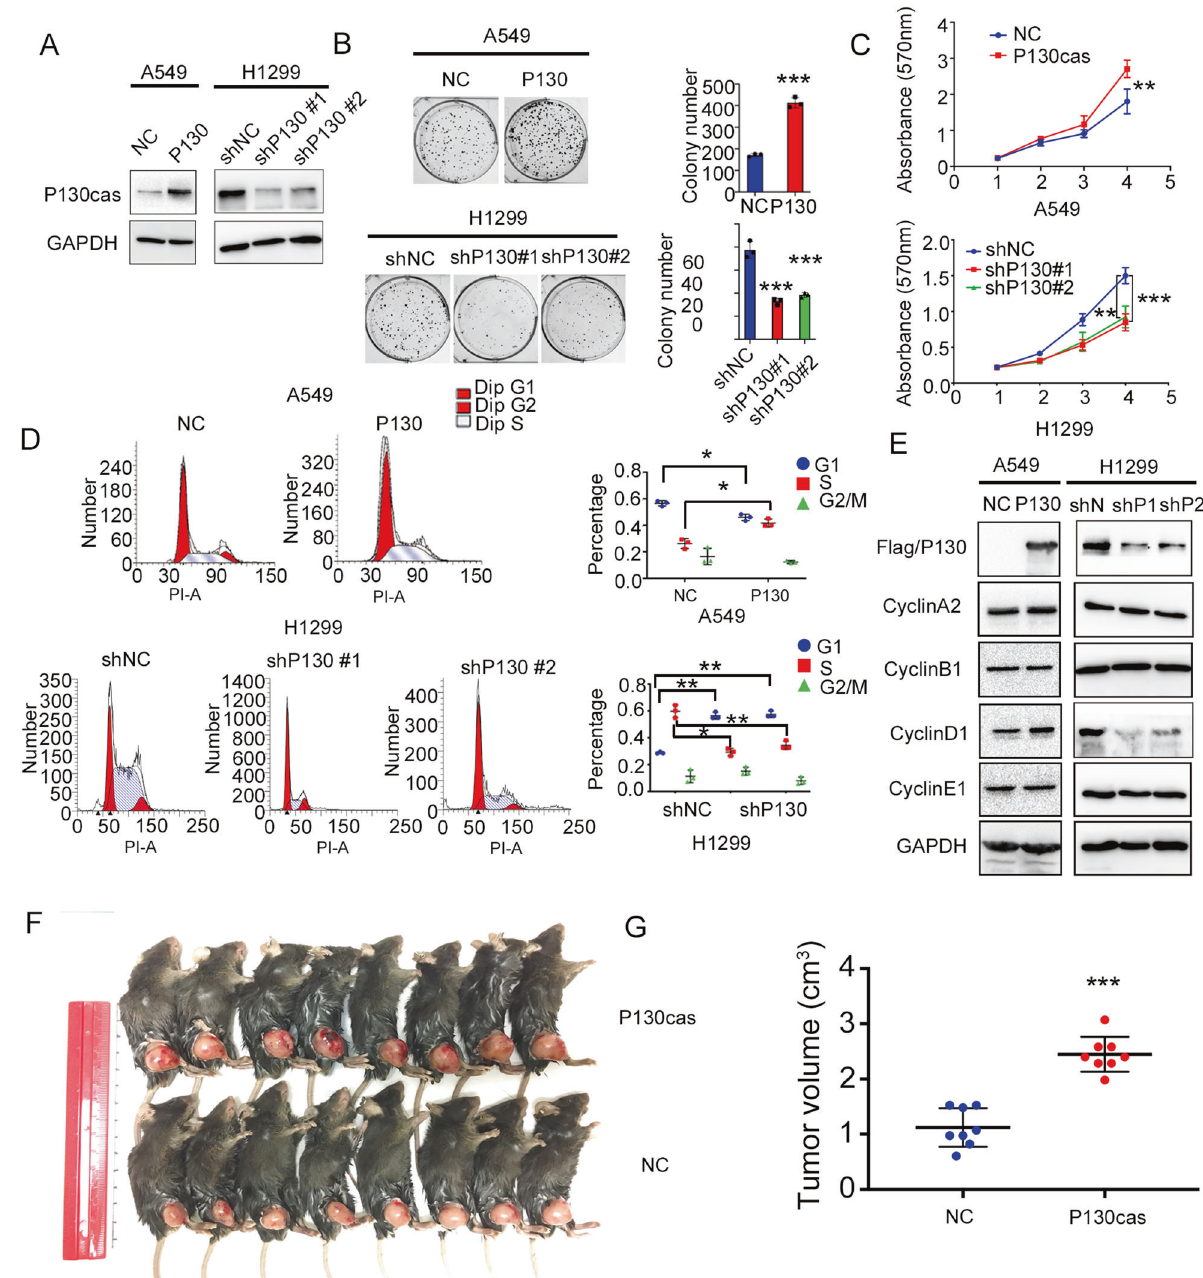
Fig. 1 Elevating P130cas enhances the proliferation of NSCLC in vitro and in vivo. A Stable up- or down-regulation of P130cas expression by two different shRNAs were con fi rmed by western blotting in A549 cells and H1299 cells, respectively. Colony formation assay ( B ), MTT assay ( C ), and cell cycle analysis ( D ) using the A549-NC and -P130cas clones, and H1299-NC and – shP130cas#1 and #2 clones. Quanti fi cation data are expressed as Mean ± SD of three independent experiments ( t -test, two-sided, * P < 0.05, ** P < 0.01, *** P < 0.001). E Western blotting assay detected the expression of cell cycle-related proteins in the A549-NC and -P130cas clones and H1299-NC and – shP130cas #1 and #2 clones (three biological replicates). F , G Representative examples of explanted tumors in the LLC-P130cas and LLC-NC study group. Quanti fi cation data are expressed as Mean ± SD of three independent experiments ( t -test, two-sided, * P < 0.05, ** P < 0.01, *** P < 0.001). For Western blot experiments, the samples derive from the same experiment and the gels/blots were processed in parallel. samples, we performed KEGG and GO pathway enrichment overexpressing P130cas showed increased resistance to X-ray analyses and Gene Set Enrichment Analysis (GSEA). The pathway irradiation compared with the control group (Fig. 2F, G). enrichment analysis results revealed that Focal adhesion (FAs) and ECM receptor interaction processes were the main deregulated P130cas interacts with and promotes stabilization of YAP, pathways between the high and low P130cas expressing group thus inducing radioresistance (Fig. 3A and Supplementary Fig. 3A, B). P130cas was a critical To provide a deeper understanding of the biological functions of factor in modulating FAs by interacting with FAK. It has been the DEGs between high and low P130cas expressing clinical tissue